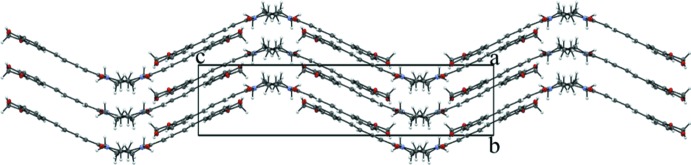
The unit-cell packing for (II) viewed down [100].